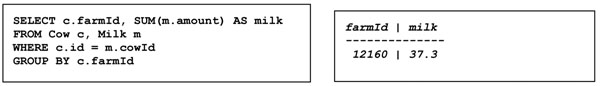
Query to compute total amount of milk for each farm